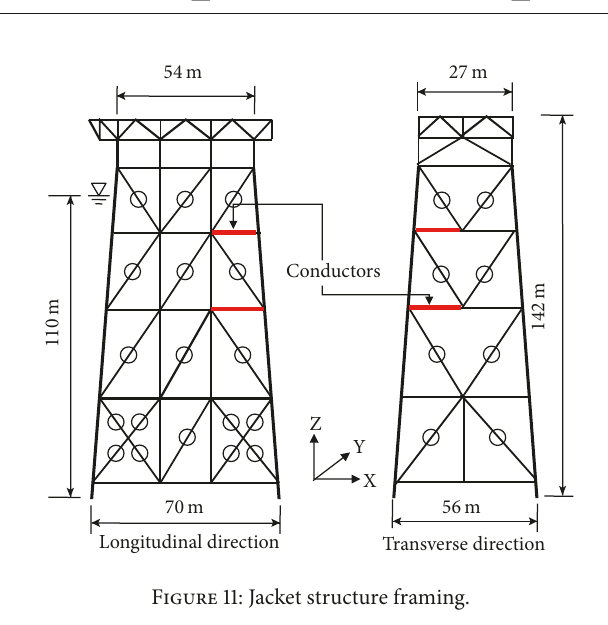
Figure 11: Jacket structure framing.